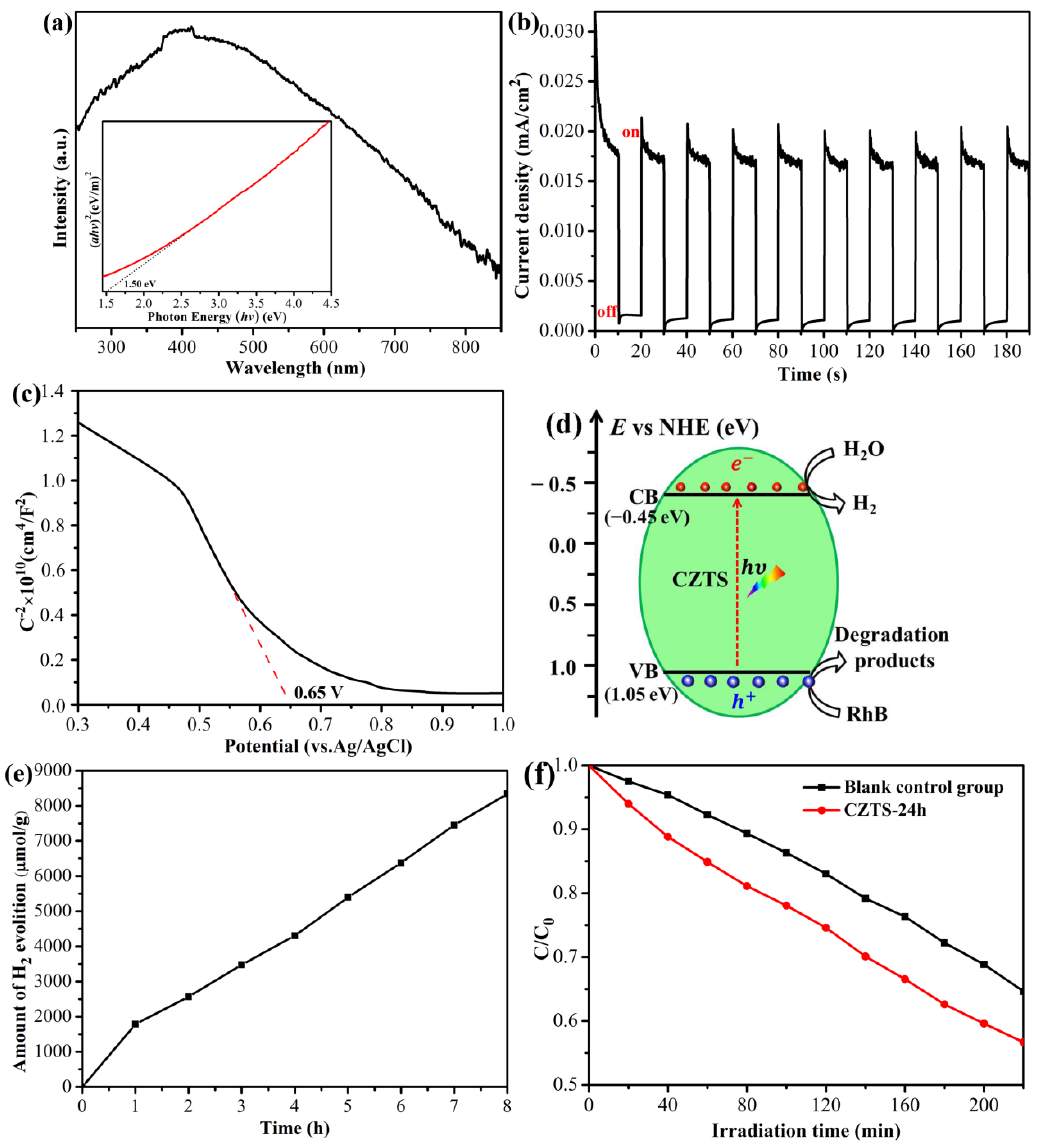
Figure 6. ( a ) UV-Vis absorption spectrum (the inset is the corresponding Tauc plot), ( b ) transient photocurrent curve, ( c ) Mott – Schottky curve, and ( d ) band alignment of CZTS-24 h; ( e ) The course of H 2 evolution and ( f ) photocatalytic degradation of RhB over CZTS-24 h photocatalyst under simulated solar irradiation.